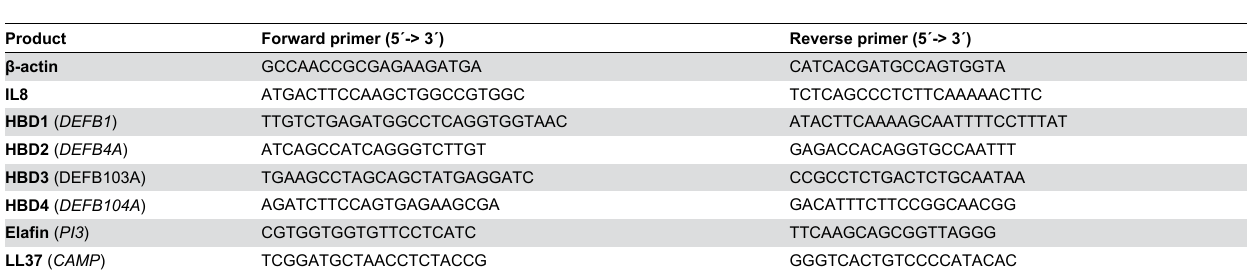
Table 1. Oligonucleotide primer pairs used for PCR